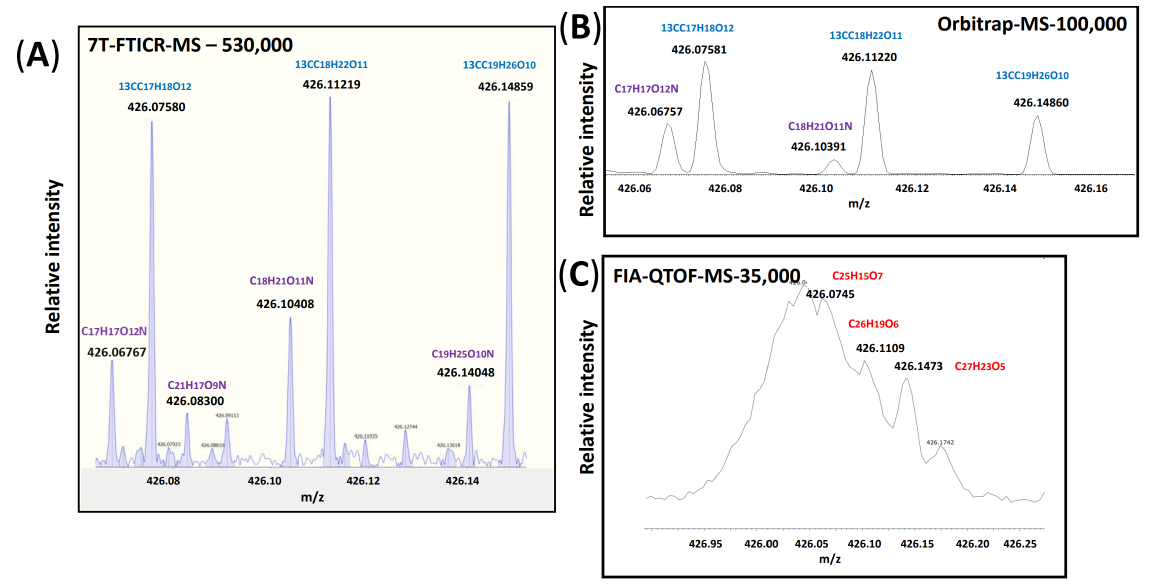
Figure 4. Comparison of raw mass spectra of SRFA from 7 Tesla Fourier transform mass Bruker Daltonics mass spectrometer at 530,000 FWHM ( A ), from LTQ-Velos-Pro Orbitrap Thermo Scientific mass spectrometer at 100,000 FWHM ( B ) and from Waters QTOF-MS by FIA at 35,000 FWHM ( C ). The indicated elemental compositions were assigned from the exact mass. Elemental compositions by FIA-QTOF-MS at 426 m/z were not correctly assigned due to the broad peaks caused by ion suppression when FIA was used in combination with the low resolution (35,000 FWHM) of the Waters QTOF mass spectrometer.